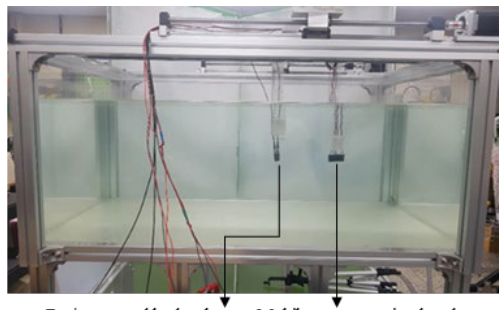
Figure 5. Water tank used in the experiment.